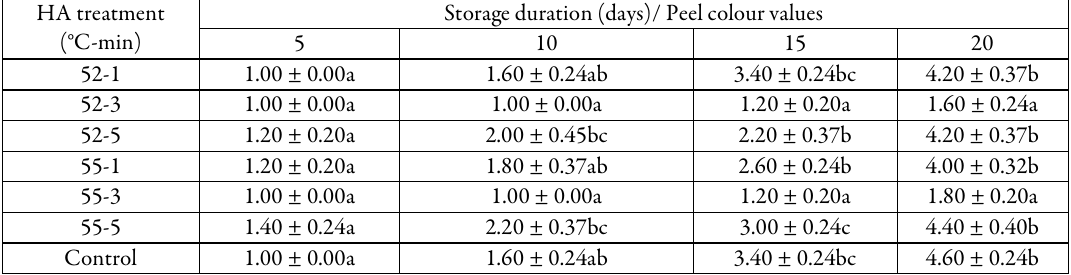
Table 1. Effect of hot air (HA) treatment on peel colour change of mango ( Mangifera indica Linn.) fruits HA treatment Storage duration (days)/ Peel colour values (°C-min) 5 10 15 20 52-1 1.00 ± 0.00a 1.60 ± 0.24ab 3.40 ± 0.24bc 4.20 ± 0.37b 52-3 1.00 ± 0.00a 1.00 ± 0.00a 1.20 ± 0.20a 1.60 ± 0.24a 52-5 1.20 ± 0.20a 2.00 ± 0.45bc 2.20 ± 0.37b 4.20 ± 0.37b 55-1 1.20 ± 0.20a 1.80 ± 0.37ab 2.60 ± 0.24b 4.00 ± 0.32b 55-3 1.00 ± 0.00a 1.00 ± 0.00a 1.20 ± 0.20a 1.80 ± 0.20a 55-5 1.40 ± 0.24a 2.20 ± 0.37bc 3.00 ± 0.24c 4.40 ± 0.40b Control 1.00 ± 0.00a 1.60 ± 0.24ab 3.40 ± 0.24bc 4.60 ± 0.24b Note: Each value represents a mean of 5 replicates and where significant, the means were separated using Duncan multiple range test (DMRT) at p≤ 0.05. Values with the same alphabet in the same column are not significantly different (p≤0.05). 1= 100% green; 2= 75% green and 25% yellow; 3= 50% green and 50% yellow; 4= 25% green and 75% yellow; 5= 100%